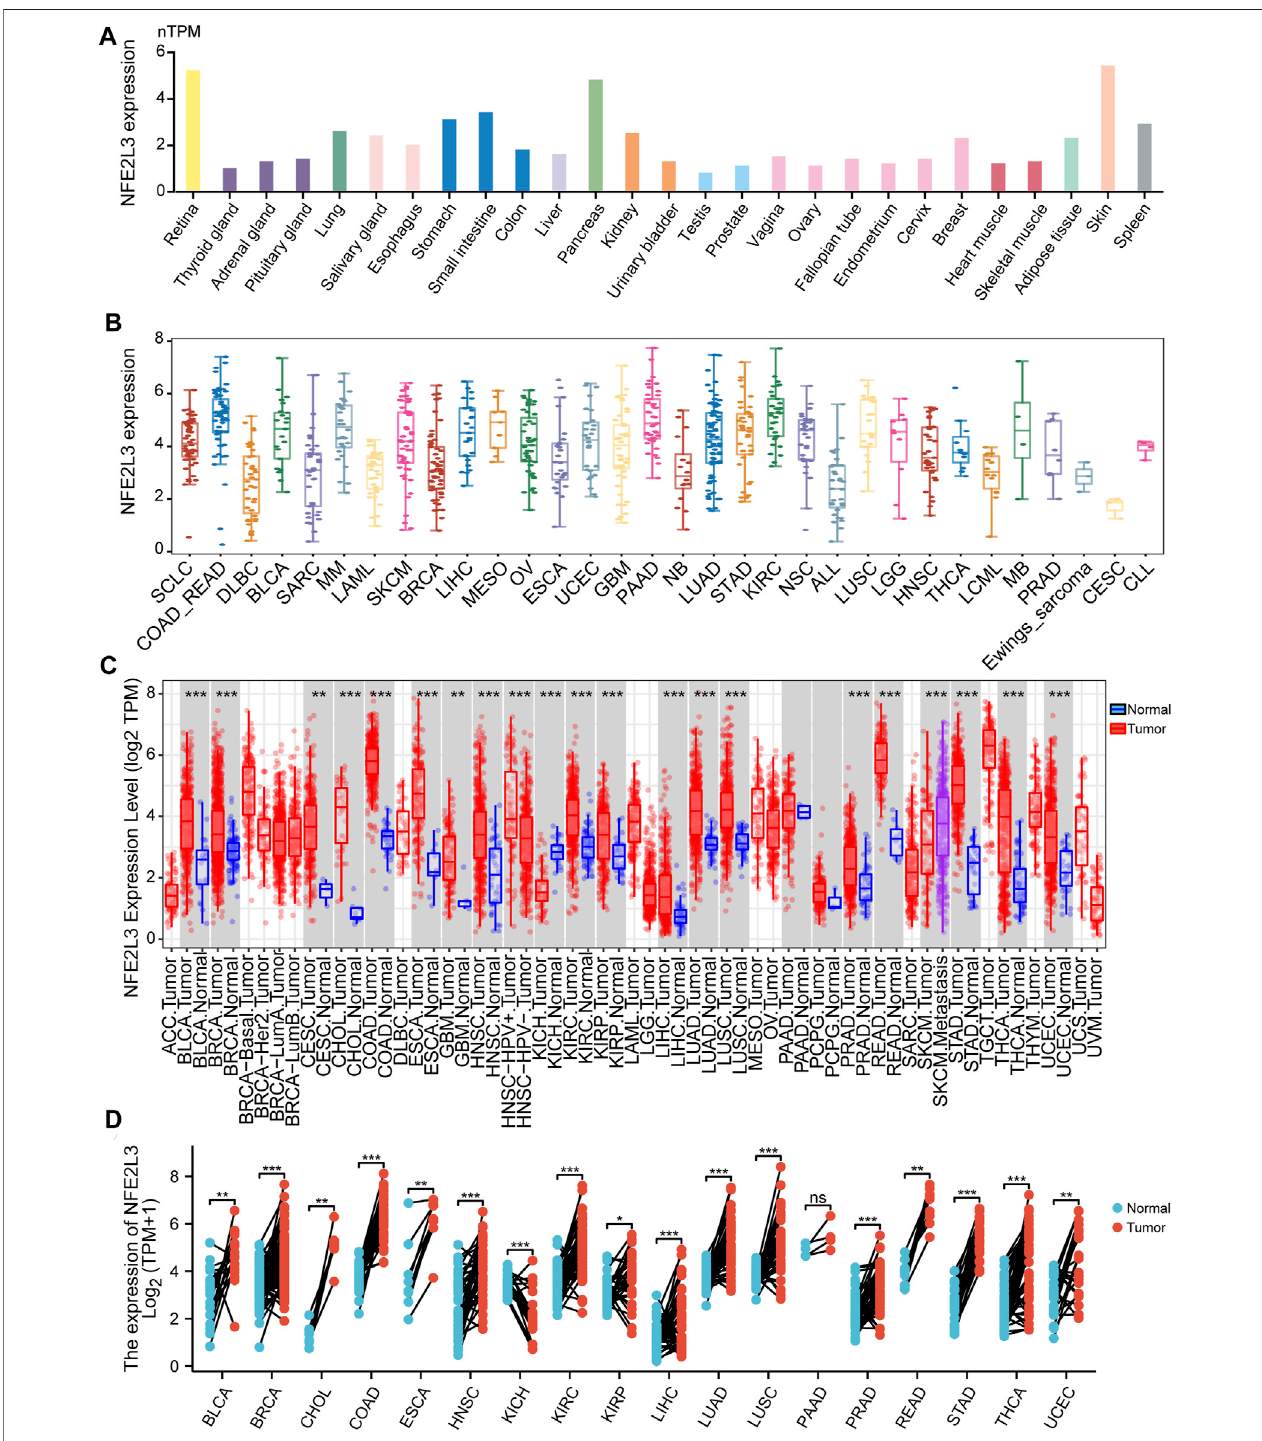
FIGURE 1 | Expression level of NFE2L3 in pan-cancer and normal human tissues. (A) The expression level of NFE2L3 in different normal tissues was analyzed by theHPAandGTEx databases. (B) TheCCLE database wasusedtoanalyzetheexpressionlevelsofNFE2L3indifferentcancercelllines. (C) TheTIMER2databasewas used toanalyze theexpression levels ofNFE2L3 intumor and normal tissues. (D) TCGA database wasused toanalyze the expression levels ofNFE2L3 in tumor tissues and adjacent normal tissues. ns, p ≥ 0.05; p , p < 0.05; pp , p < 0.01; ppp , p < 0.001.